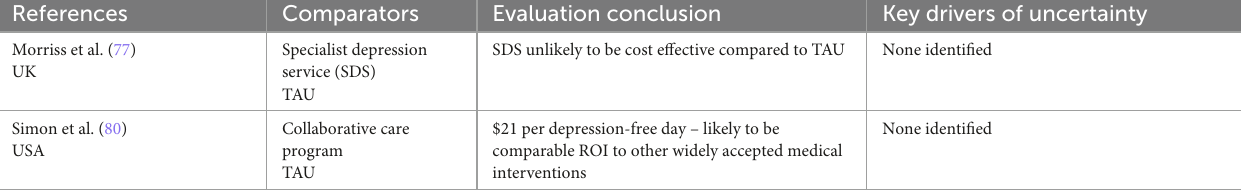
TABLE 4D Summary of authors’ conclusions, and key drivers of uncertainty for economic evaluations of service-level